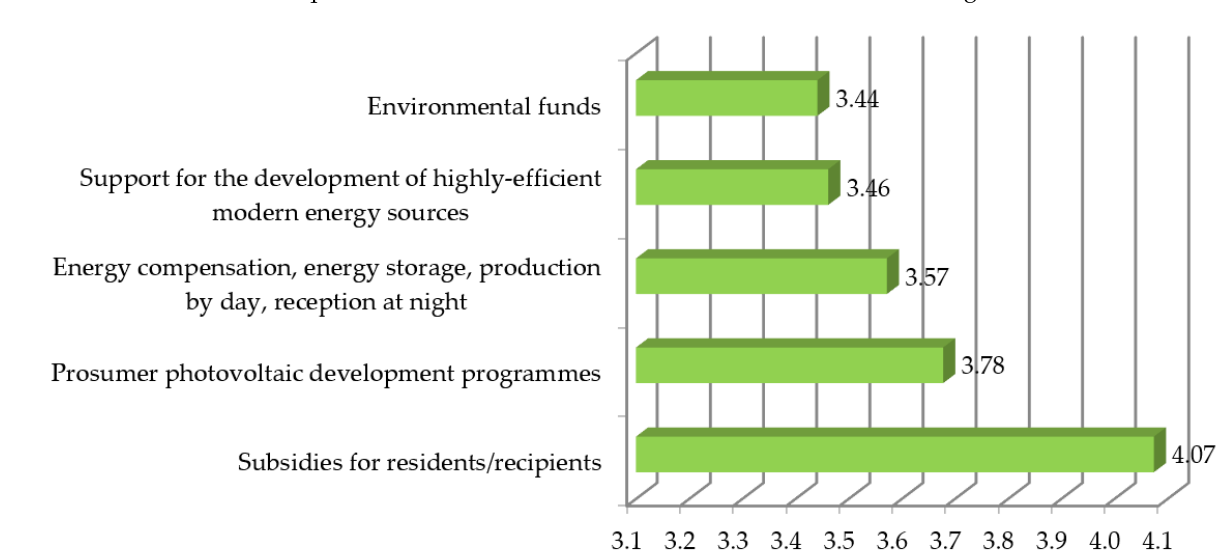
Figure 4. Evaluation of decarbonization activities that should be financed from local funds—ranking— average ratings. Source: Own study based on the conducted research, n = 444.